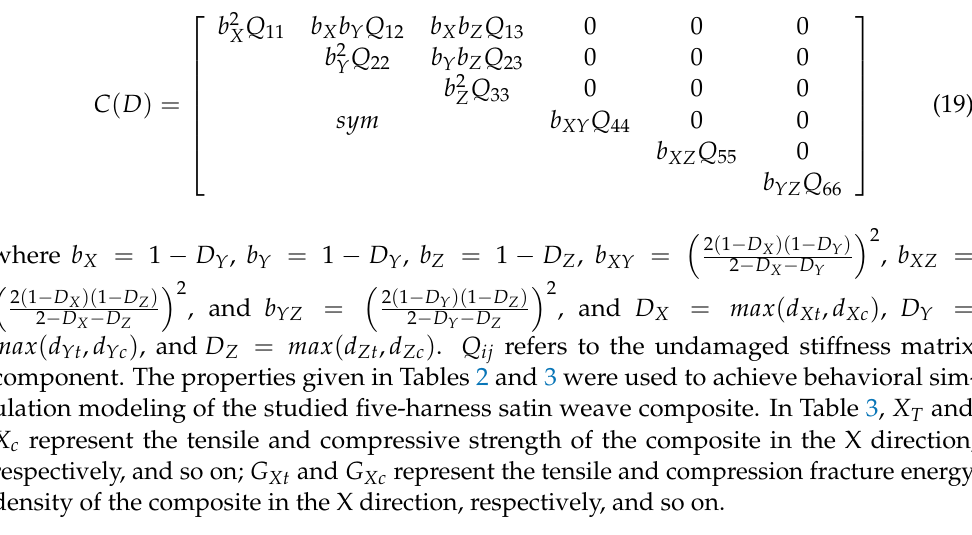
Table 2. Mechanical properties of SiC f /SiC composite [30].